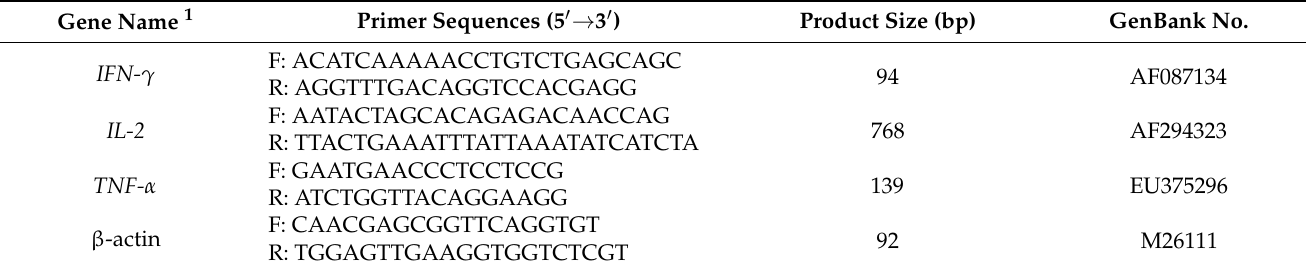
Table 2. Primer sequences used for quantitative